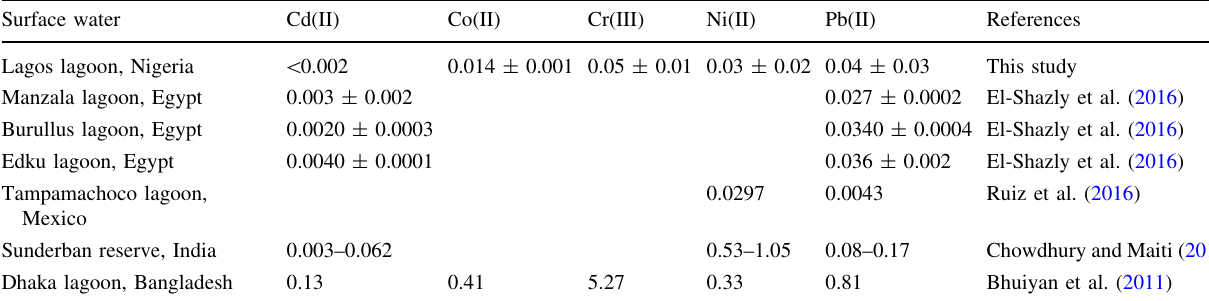
Table 6 Comparison of metal concentrations (mg/L) in the study with previous studies in other countries Surface